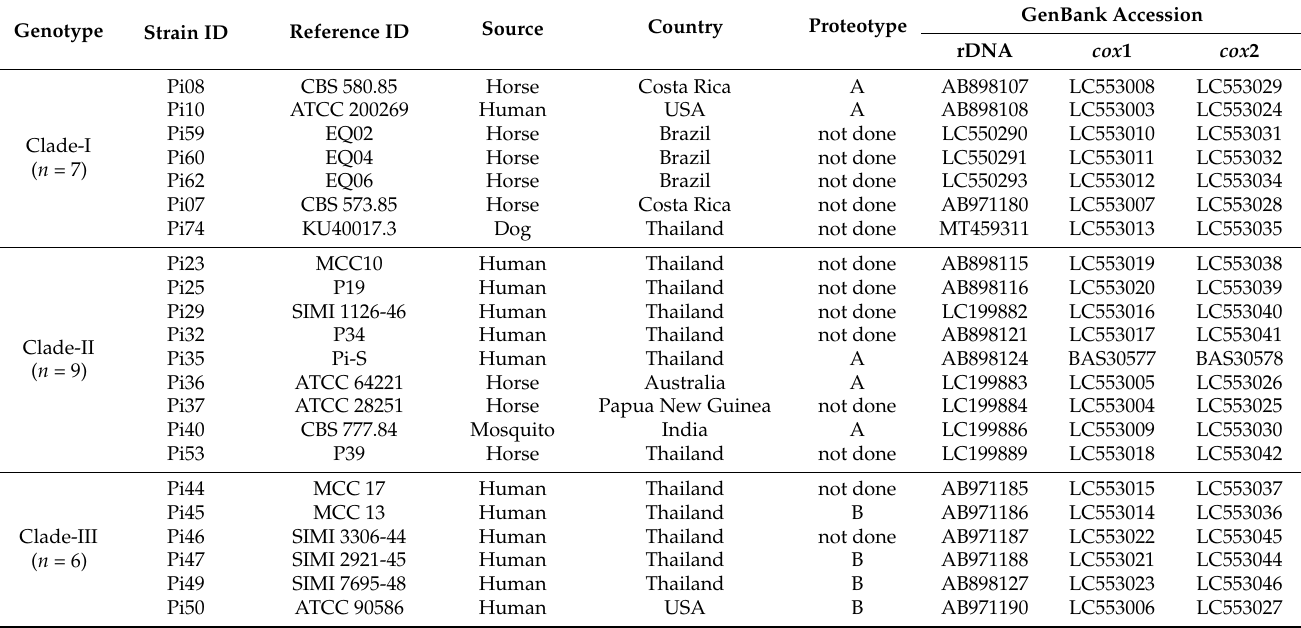
Table 3. Twenty-two clinical strains of P. insidiosum used for proteomic and phylogenetic analyses in this study. The table contains strain IDs, reference IDs, affected hosts (i.e., humans or animals), country of origins, mass spectrometry-based prototypes, and GenBank accessions (i.e., rDNA, cox 1, and cox 2).